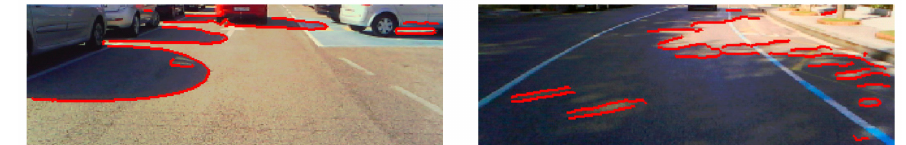
Figure 7. Shadow edge detection results obtained after applying the three properties all